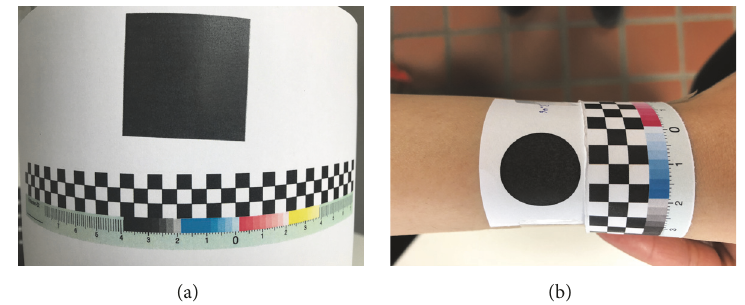
Figure 7: (a) A phantom example. (b) A phantom image which is placed on a person’s arm. Table 1: Results for ruler-based measurements. Values for absolute and relative error are given as mean ± standard deviation. Exclusion is due to converging the grid pattern in the phantom area or phantom area being outside of the grid. Type of image